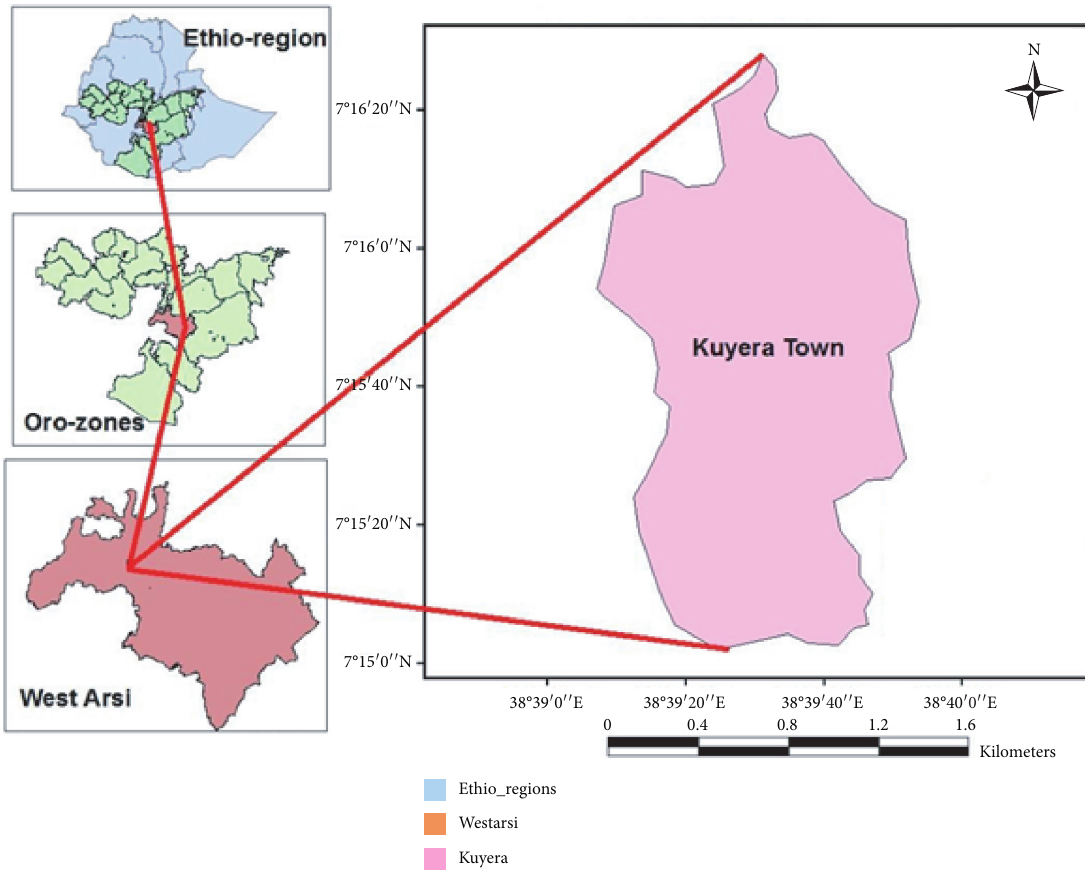
Figure 1: Map of the study